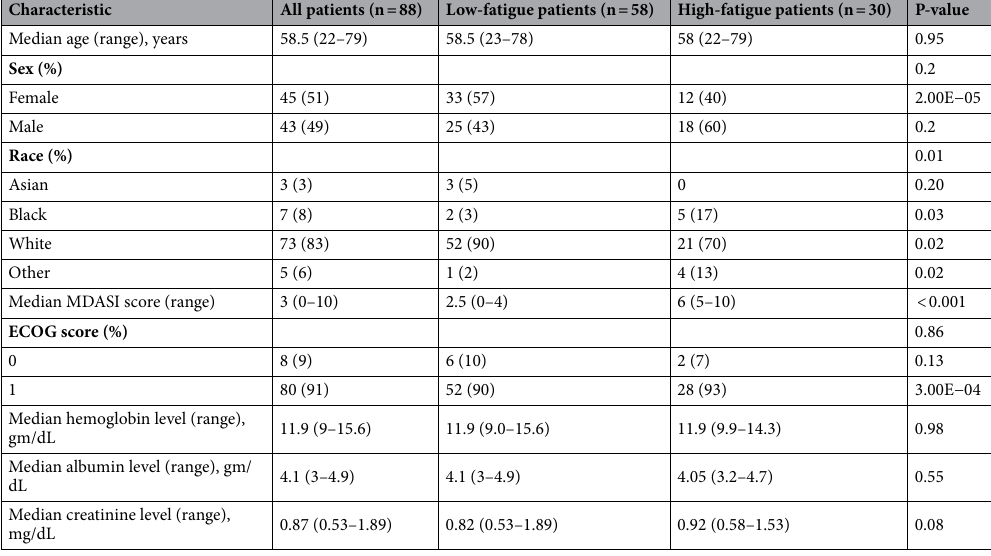
Table 1. Patient